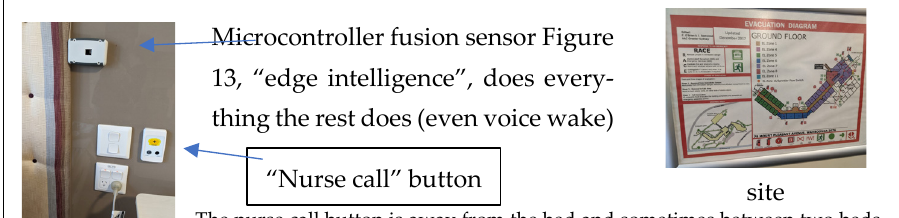
Figure 12. Industry-issued figure of a device ecosystem.